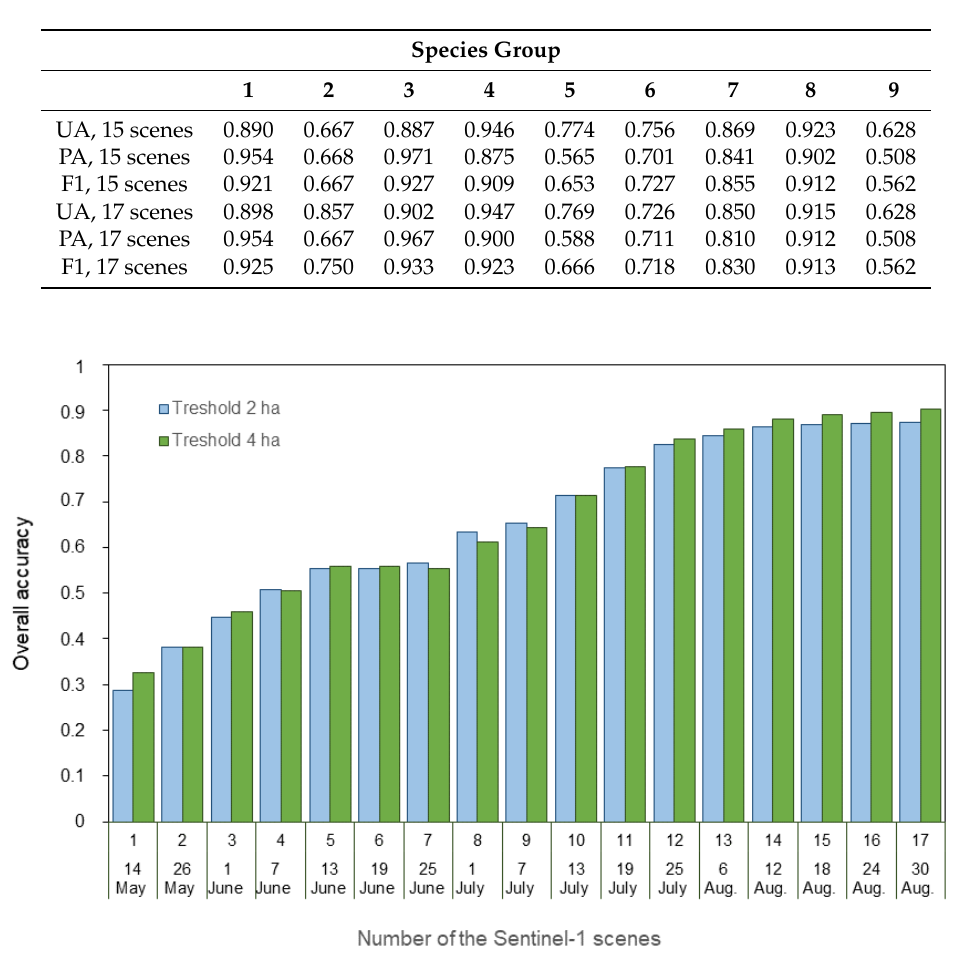
Table 6. An example of user’s and producer’s accuracies (UA and PA) and F1 scores by species groups with all the Sentinel-1 scenes when the first scene was either from 1 June, 15 scenes, or 14 May, 17 scenes. With 15 scenes, the data correspond to Table 5.